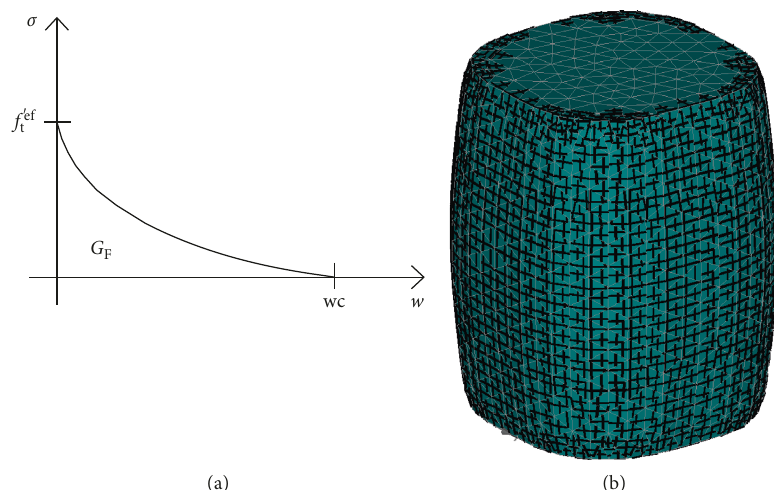
Figure 3: Finite element model. (a) Exponential crack-opening law. (b) Deformed shape and crack pattern for unconfined columns.